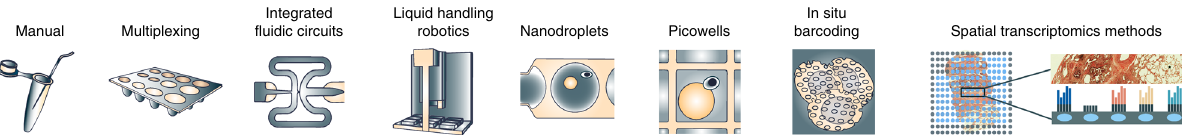
Fig. 1 Development of single-cell technologies. Signi fi cant technology developments have enabled the pro fi ling of large numbers of cells in parallel by single-cell transcriptomics. Initial manual methods allowed single-cell transcriptomic analysis on only a few cells. The development of integrated fl uidic circuits and the introduction of liquid handling robots into the process brought cell numbers to several thousand and then further increased with nanodroplet and picowell technologies. The introduction of in situ barcoding has increased throughput even further to hundreds of thousands of cells with the latest developments in spatial methods integrating the spatial location of transcriptomic information within tissue